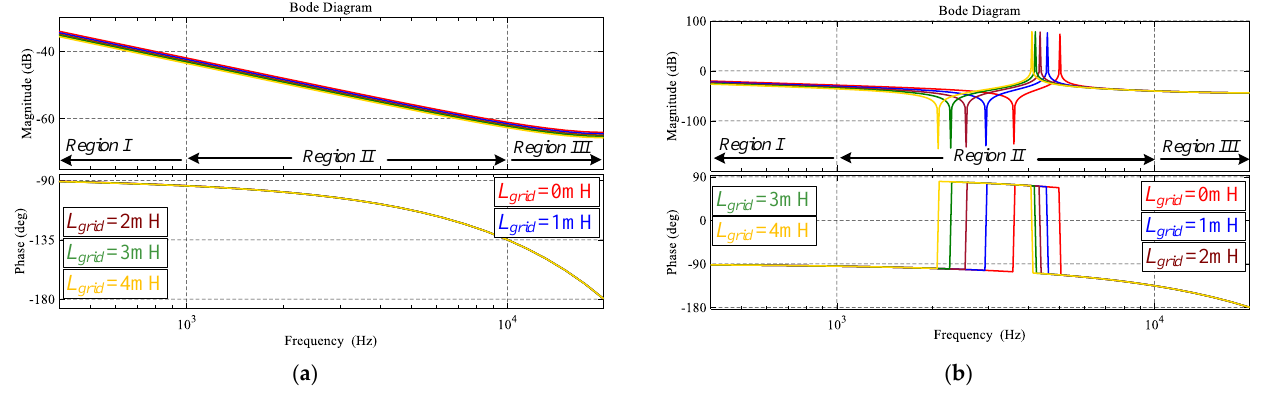
Figure 3. Frequency response characteristics of the system under L grid variations ( a ) L filter type GcI; ( b ) LCL filter type GcI.